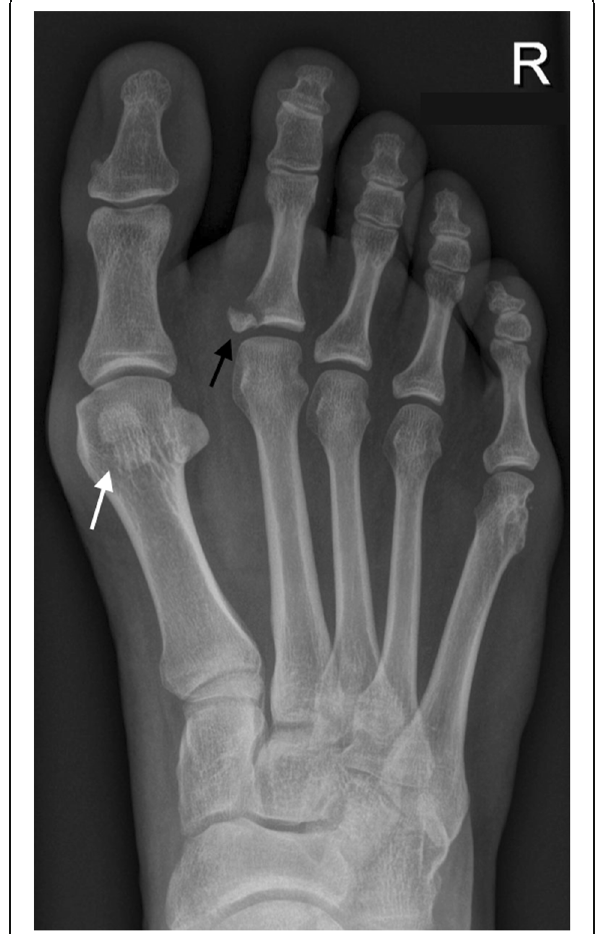
Fig. 11 A 41-year-old woman referred after kite surfing trauma. Incidental finding of a medial bipartite sesamoid (white arrow). Note the smooth, rounded contours of the bipartite components. The added volume of the bipartite components adds to a larger volume than a single sesamoid. Note mild hallux valgus deformity and a fracture of the base of the proximal phalanx in the second toe (black